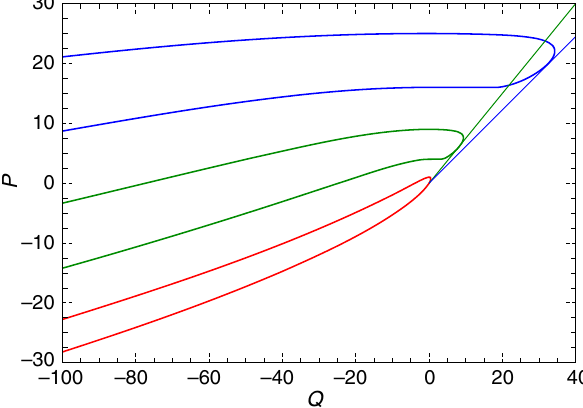
FIG. 4. Lowest real eigennumbers of Eq. (24) and (25). Thin straight lines are tangent to the curves of corresponding